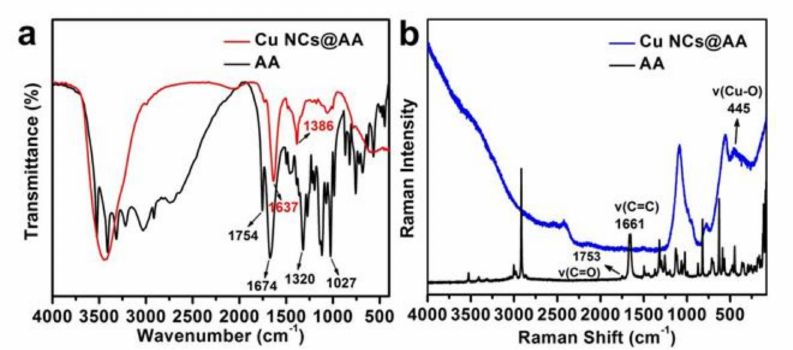
Figure 2. ( a ) Fourier transform infrared (FTIR) spectra of the as-prepared Cu NCs@AA and AA. ( b ) Raman spectra of Cu NCs@AA and AA.